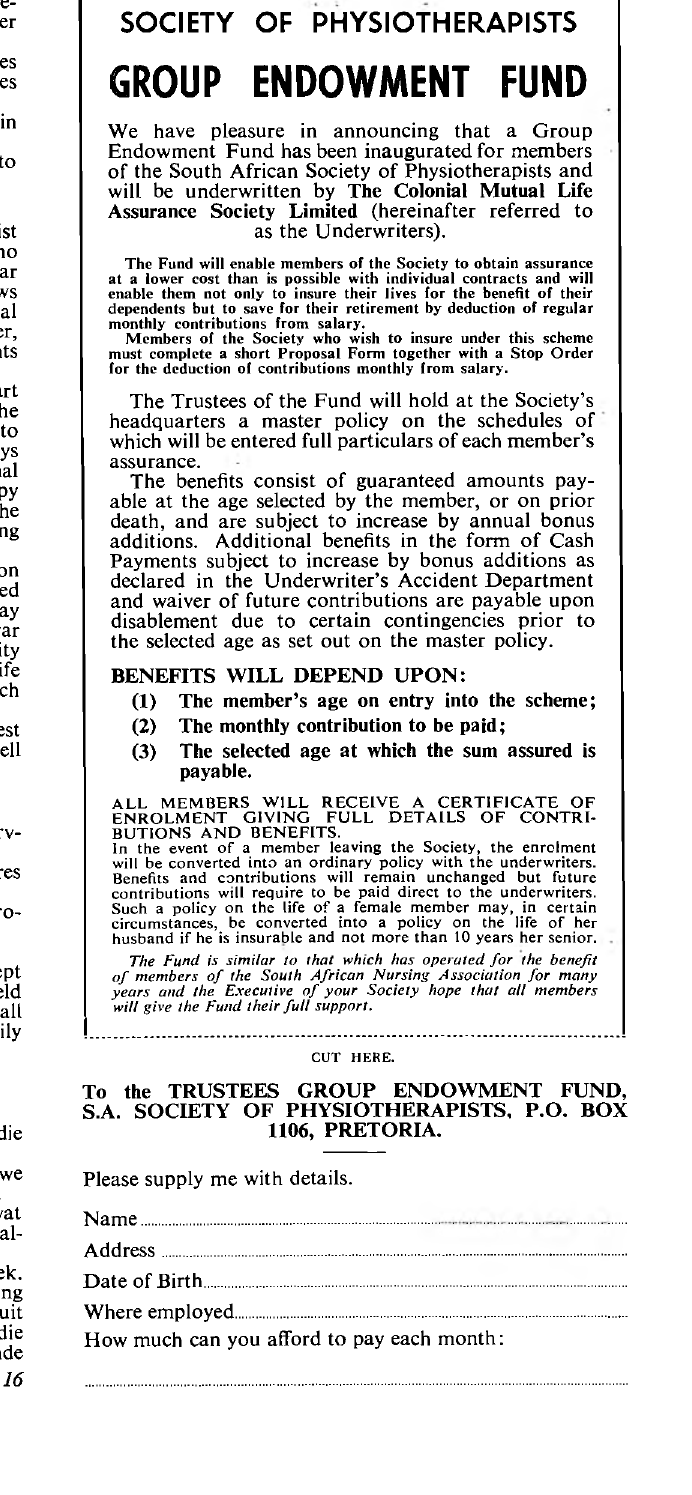
Fig. 31. Bowls. This shows one of our two regulation size greens. It is most socializing and relaxing. Mixed groups. Fig. 32. Swimming bath (17 ft. X 37 ft.), mixed groups. Socializing and stimulative. Fig. 33. A recreation committee meeting. All the repre­ sentatives of the patient community are present with member of team. Fig. 34. The dining room representative hands serviettes :o new patients, conducts them to their tables and introduces them. Fig. 35. The Y.M.C.A. canteen where patients entertain \ isitors. Fig. 36. A rehabilitated patient escorts a new patient to town and is responsible for him until he